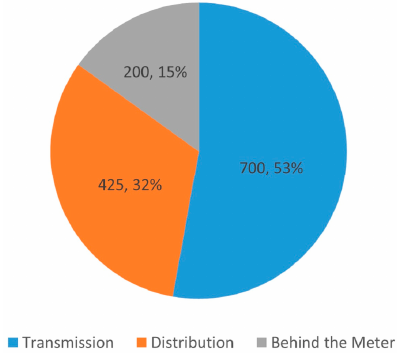
Figure 5. California 2020 energy storage target by network area (created from data obtained from [11]).